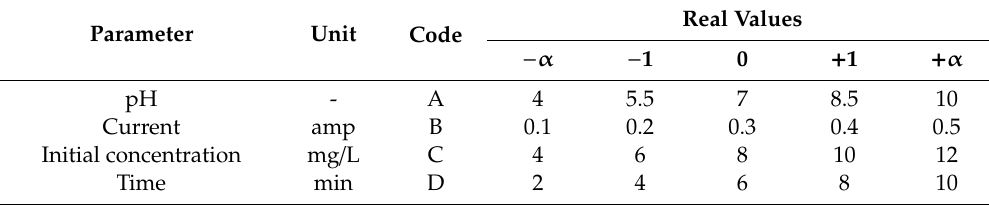
Table 1. Set of coded and actual values adopted for central composite design (CCD).